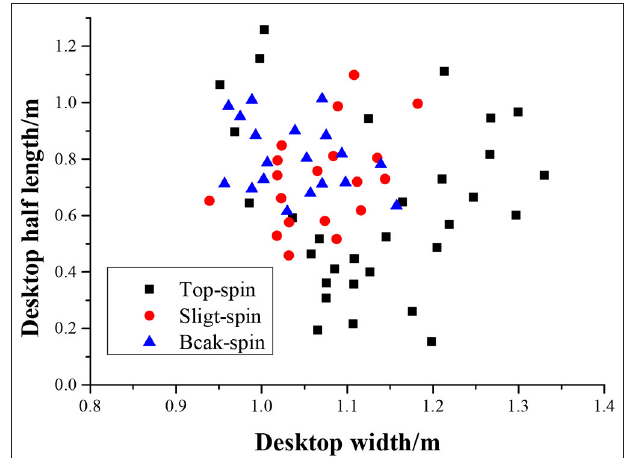
FIGURE 10 | The detection distribution of the three difficulty services.